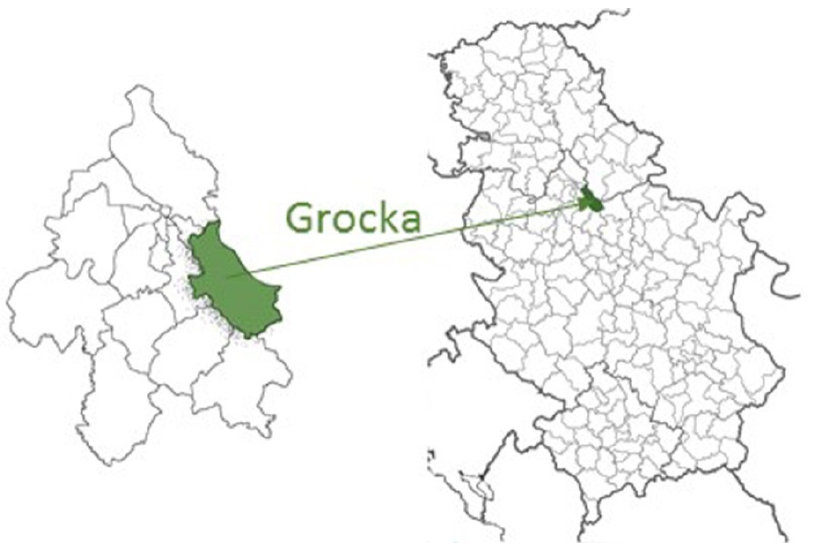
Figure 1. The location of the study area (44°45 ′ N, 20°35 ′ E Serbia, 130 m a.m.s.l) at different scales.